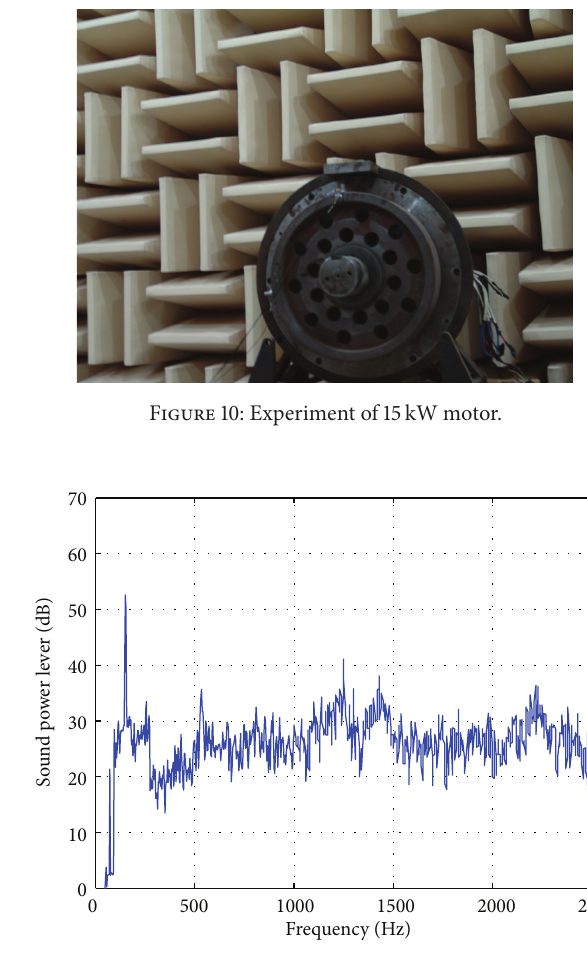
Figure 11: Spectrum of electromagnetic noise sound power lever 𝐿 𝐼 of 15 kW